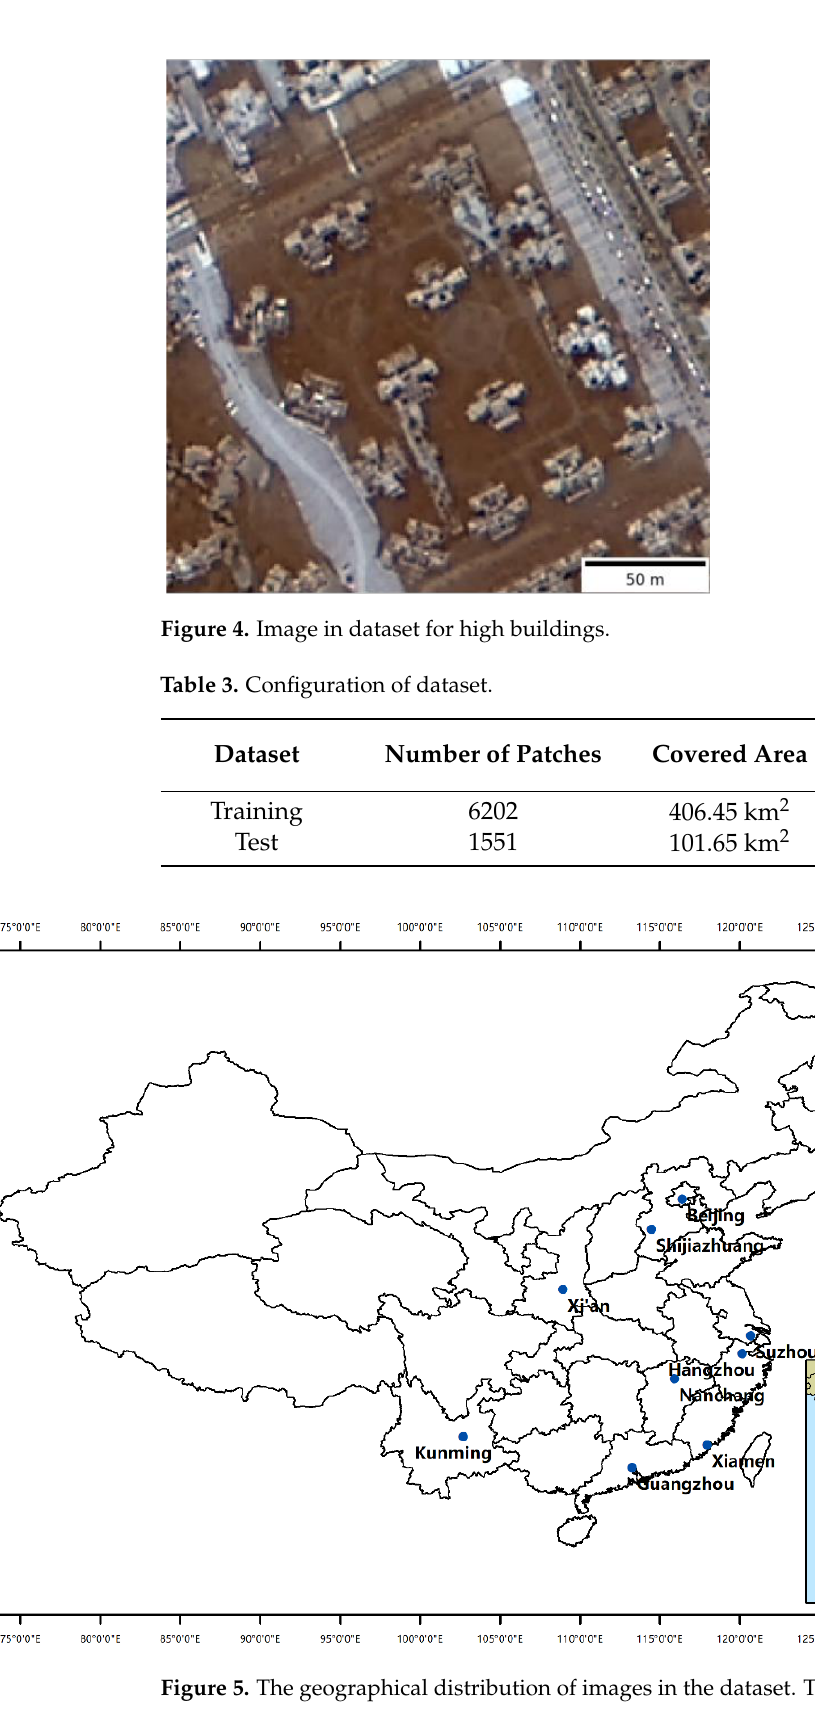
Figure 5. The geographical distribution of images in the dataset. This figure is from [3].